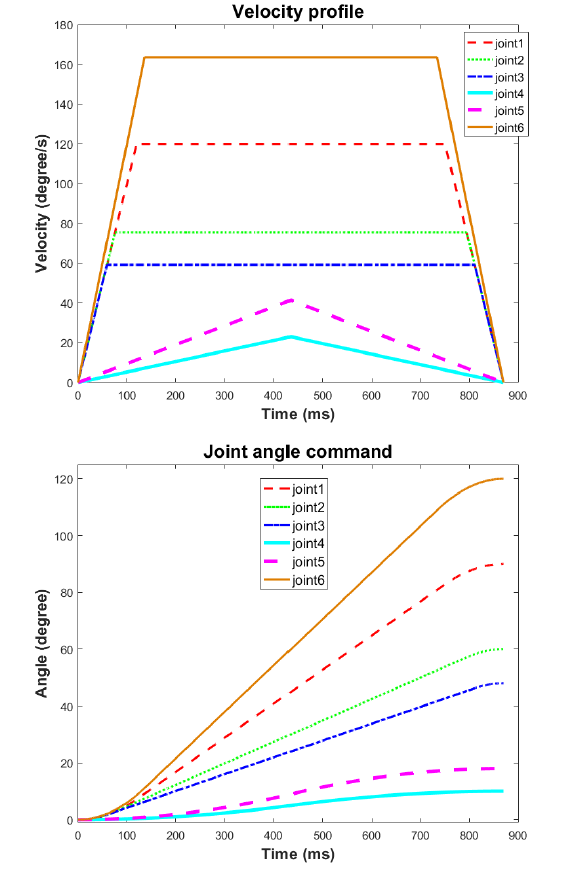
Figure 9. Joint angle trajectory planning